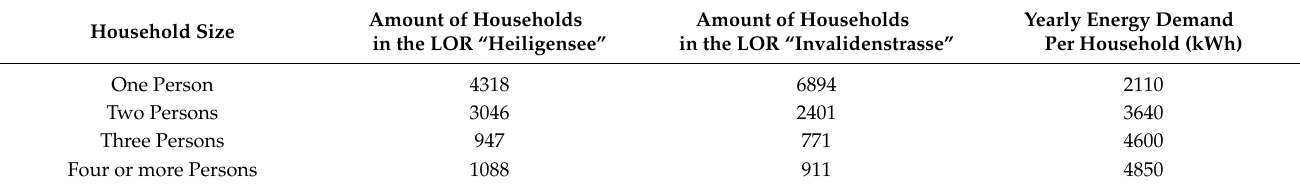
Table 6. Amount of households in the LORs “Heiligensee” and “Invalidenstrasse” and their yearly energy demand. Household